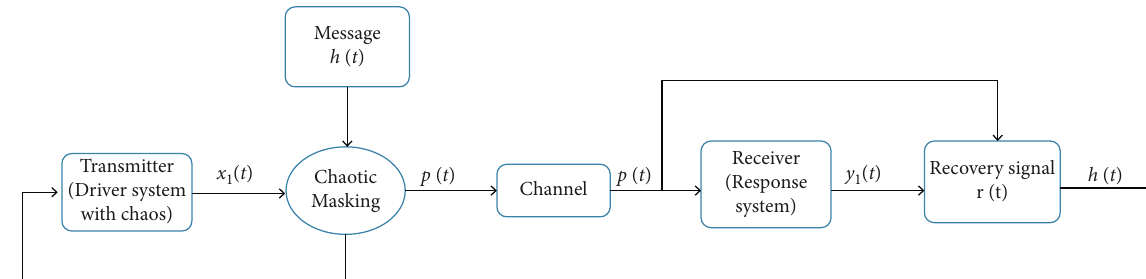
Figure 13: The schematic diagram of the proposed secure communication